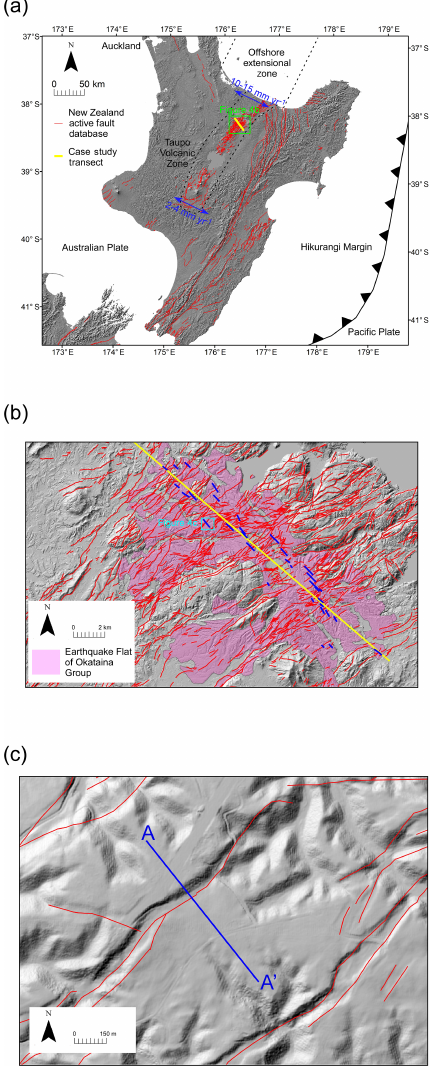
Figure 4. Taupo Volcanic Zone case study. Base images of ( a , b , and c ) are lidar hillshade maps of the North Island and Taupo Vol- canic Zone, New Zealand. (a) Tectonic features of New Zealand where the green box represents the enlarged image in (b) . The red fault traces are from the New Zealand Active Faults Database (NZAFD). Active faults have deformed the ground surface of New Zealand within the last 125000 years. The blue arrow and rate rep- resent geologic extension rates from geodetic and Quaternary fault data (Villamor et al., 2017). The yellow line represents the case study transect. (b) Fault scarp profiles used in this case study are shown in blue and are distributed along the case study transect shown in yellow. Mapped faults in the region are shown in red (NZAFD). For simplicity, only the Earthquake Flat Formation of the Okataina Group outcrops is shown from the Geologic Map of New Zealand Project (GMAP). This is the formation that was ana- lyzed in this study. The light blue box represents the map extent of part (c) . (c) Lidar hillshade map of the location of the profile shown in Fig. 2 and analyzed in Fig.